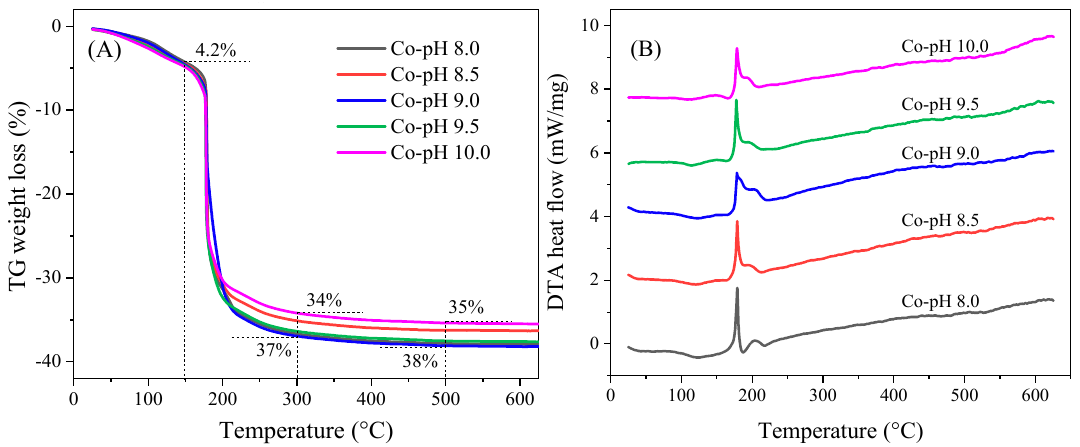
Figure 1. ( A ) thermogravimetric (TG) and ( B ) differential thermal analysis (DTA) curves of cobalt precursors prepared at different pH values.